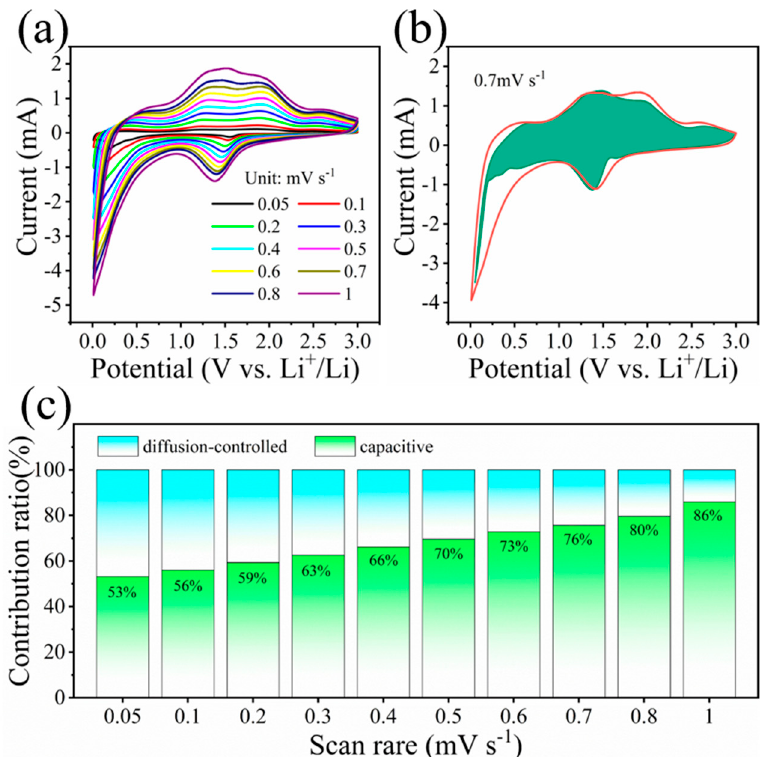
Figure 4. ( a ) CV curves of α− MoO 3 /MXene ranging from 0.05 mV s − 1 to 1 mV s − 1 . ( b ) Capacitive charge storage contribution (green) at 0.7 mV s − 1 . ( c ) Capacitive contribution ratios at different scanning rates of α− MoO 3 /MXene.